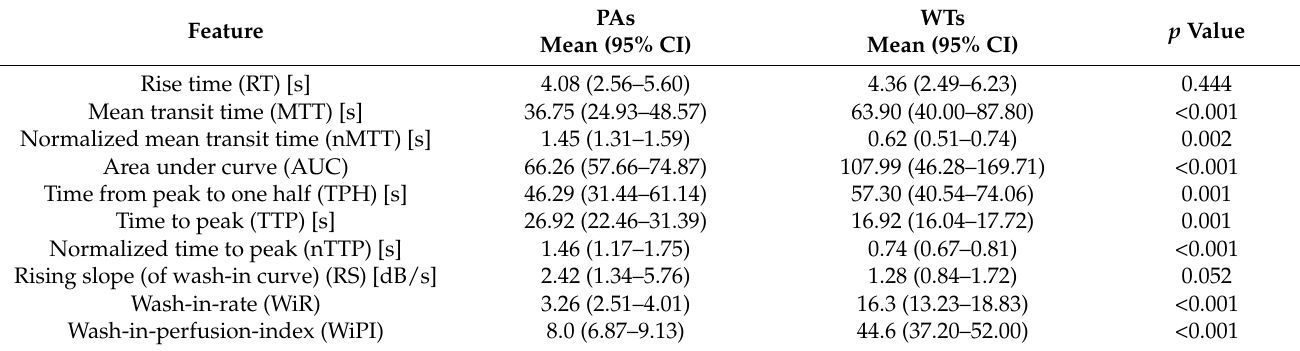
Table 2. Comparison of quantitative CEUS characteristics between PAs and